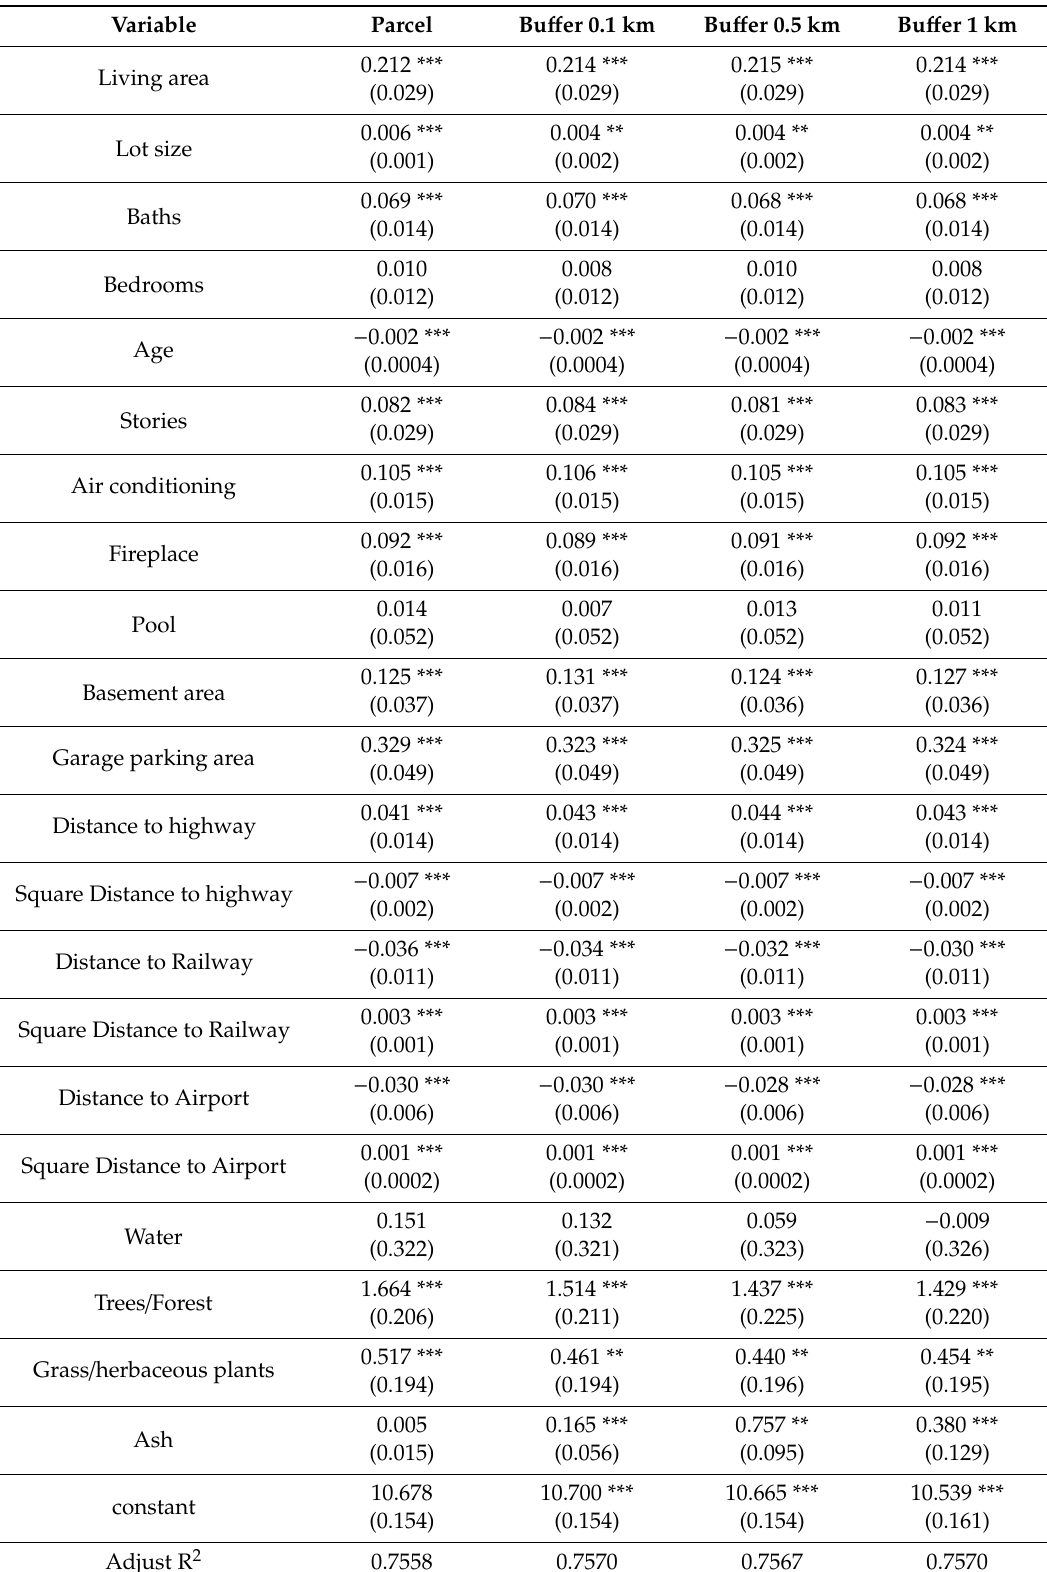
Table 3. Coe ffi cient Estimates of Hedonic Model 1, Home Sales 2008–2011 ( N =